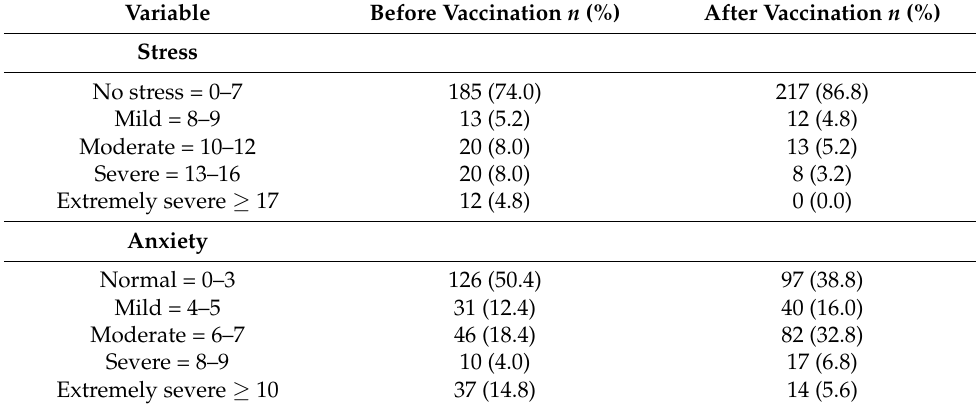
Table 1. Levels of stress and anxiety before and after administering the COVID-19 vaccine ( n = 250). Variable Before Vaccination n (%) After Vaccination n (%)